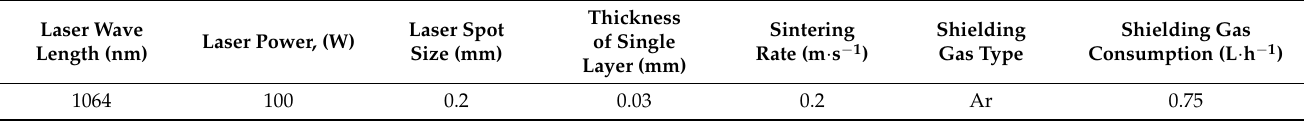
Figure 1. Morphology ( a ) and size distribution ( b ) of powder particles used for the production of samples, and sample drawing ( c ). Table 1. Characteristics of LPBF process parameters.